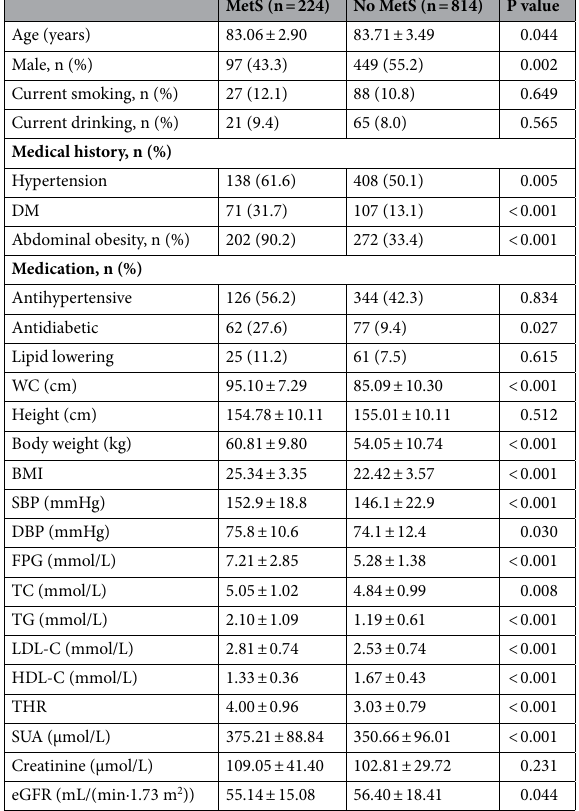
Table 1. Baseline characteristics of very elderly according to MetS (Chinese criteria). Data are expressed as mean ± standard deviation for continuous variables or number (percentage) for categorical variables. BMI